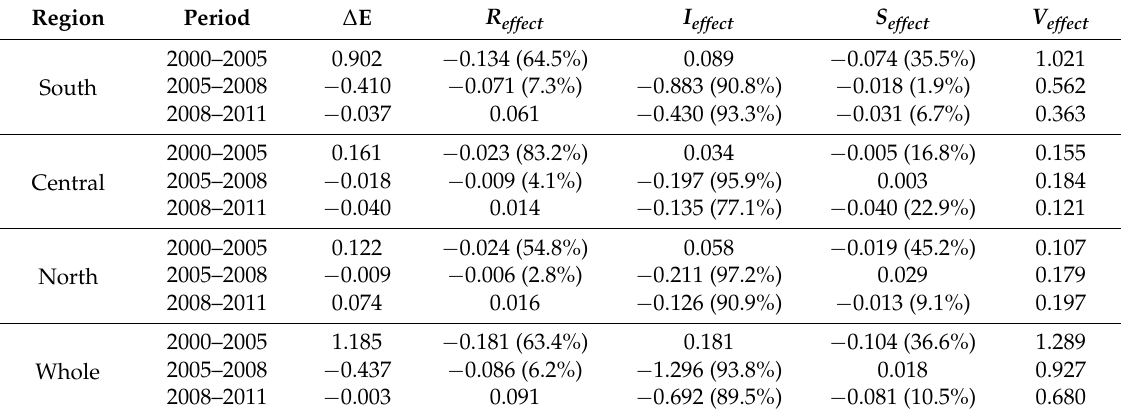
Table 4. Regional decomposition results of SO 2 emission changes in Jiangsu province (unit: Mt). Region Period